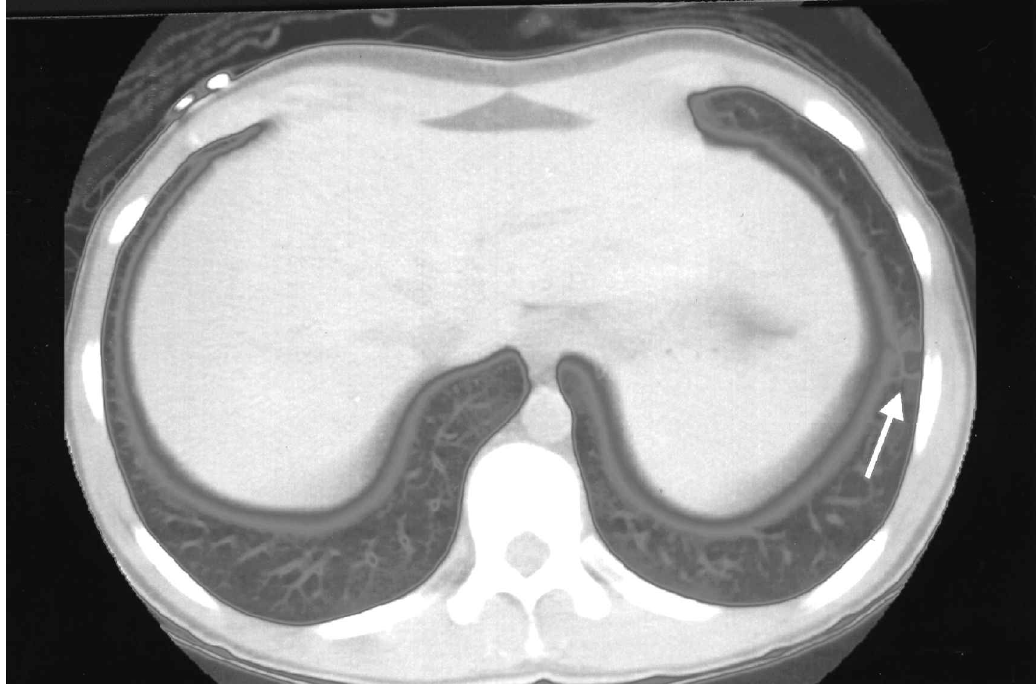
Figure 1. An 18-year-old male with high grade synovial sarcoma of arm diagnosed 3 months earlier.Helical CT shows 0.8 3 0.6 cm left lower lobe lung nodule (arrow) not visible on prior helical CT. Histopathological examination of wedge resection specimen demonstrated a benign intrapulmonary lymph